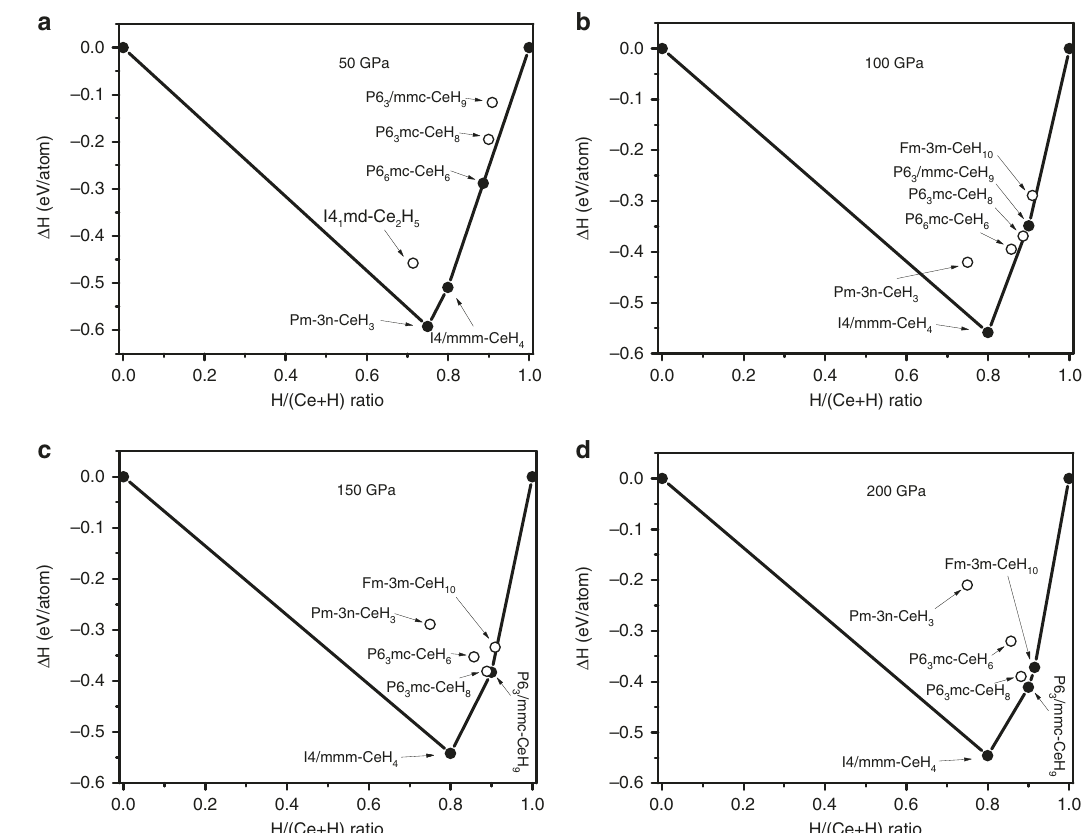
Fig. 4 Convex hull diagram of Ce – H system. Predicted formation enthalpy of Ce 1 − x H x as a function of H concentration at selected pressures. Open circles above the convex hull show unstable compounds with respect to decomposition into the two adjacent phases on the convex hull, while solid circles show thermodynamically stable compounds